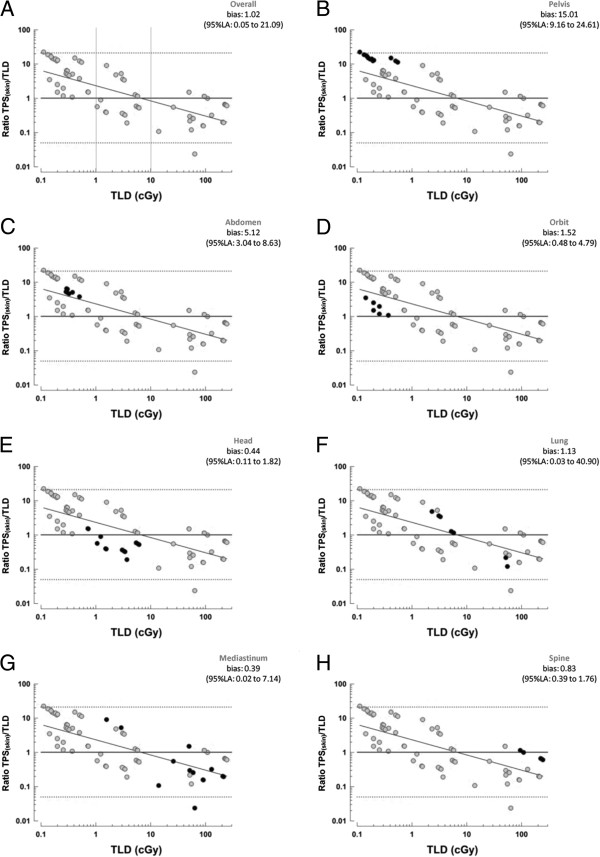
Bland–Altman plots of agreement between TLD and TPS measurements. Bland–Altman plots of overall agreement between TPSskin and TLD measurements, stratified by specific anatomical site (dark points): (A) Overall agreement (bias, 1.02; 95% LA, 0.5 to 21.09); (B) Pelvis (bias, 15.01; 95% LA, 9.16 to 24.61); (C) Abdomen (bias, 5.12; 95% LA, 3.04 to 8.63); (D) Orbit (bias, 1.52; 95% LA, 0.48 to 4.79); (E) Head (bias, 0.44; 95% LA, 0.11 to 1.82); (F) Lung (bias, 1.13; 95% LA, 0.03 to 40.90); (G) Mediastinum (bias, 0.39; 95% LA, 0.2 to 7.14); (H) Spine (bias, 0.83; 95% LA, 0.39 to 1.76).